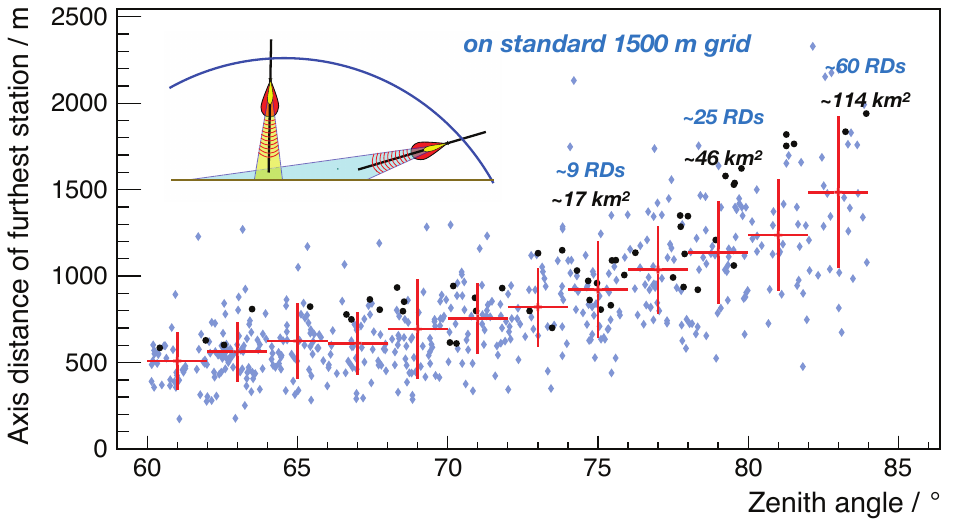
Figure 5. Furthest axis distance at which a radio signal above noise background has been detected with AERA as a function of the air-shower zenith angle [31].